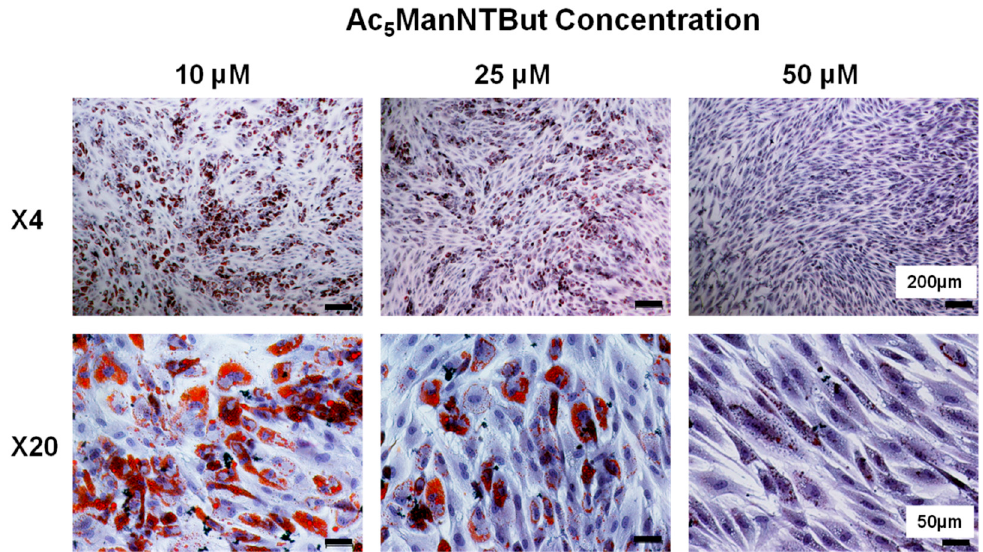
Figure 7. Dose-response of Ac 5 ManNTBut-treated hASCs. hASCs were cultured in adipogenic differentiation medium with the indicated concentrations of Ac 5 ManNTBut and visualized by phase-contrast microscopy after Oil red O staining on Day 7 at 4× or 20× magnification. Lipid droplets were stained red and nuclei were stained blue.